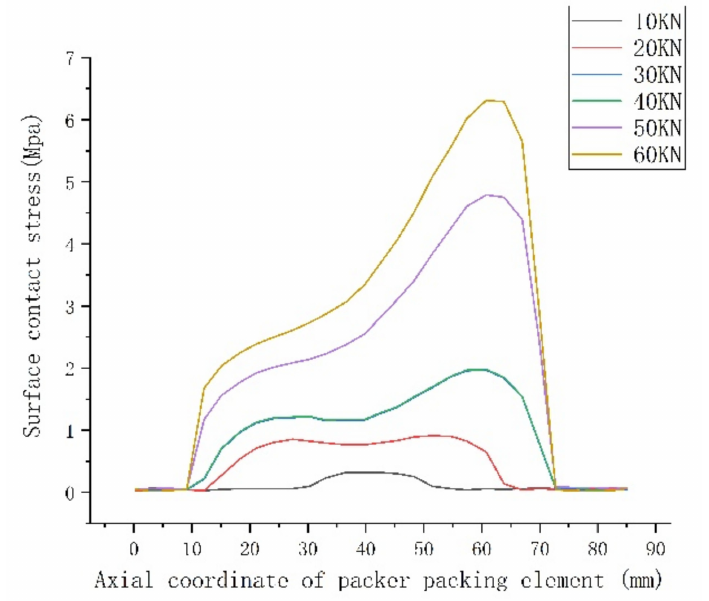
Figure 5. Contact stress of the packer’s packing element without an end-guard ring.